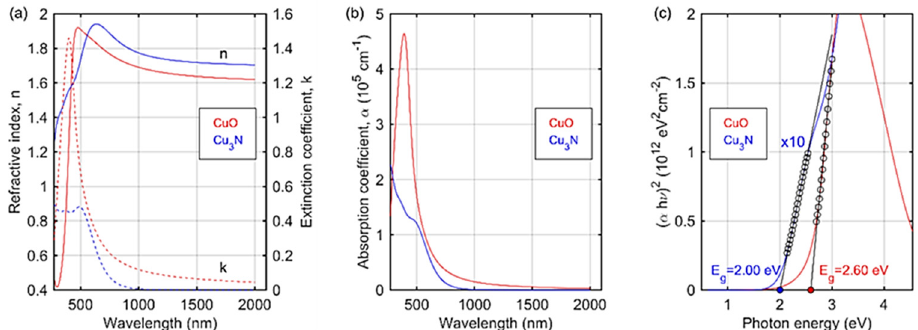
Figure 10. ( a ) The refractive index and the extinction coefficient, ( b ) absorption coefficient and ( c ) the Tauc plot for the CuO and Cu 3 N layers.